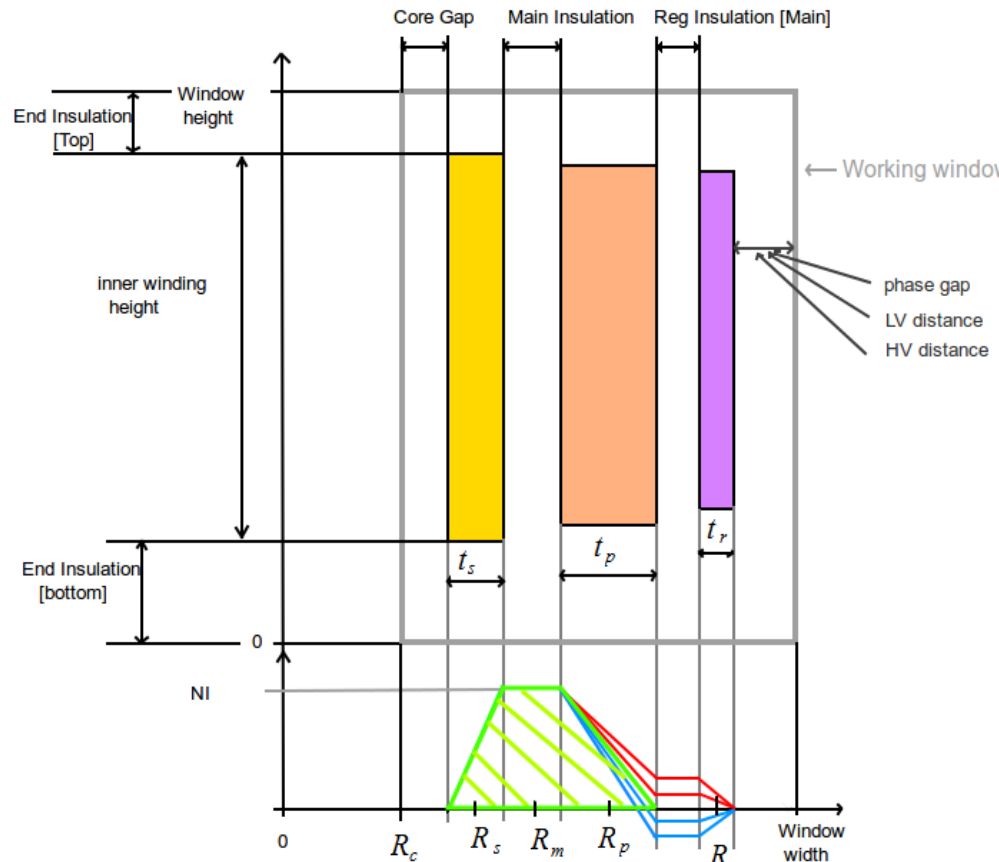
Fig. 1. Schematic view of the applied electrical and geometrical parameters in the transformer “Working window”